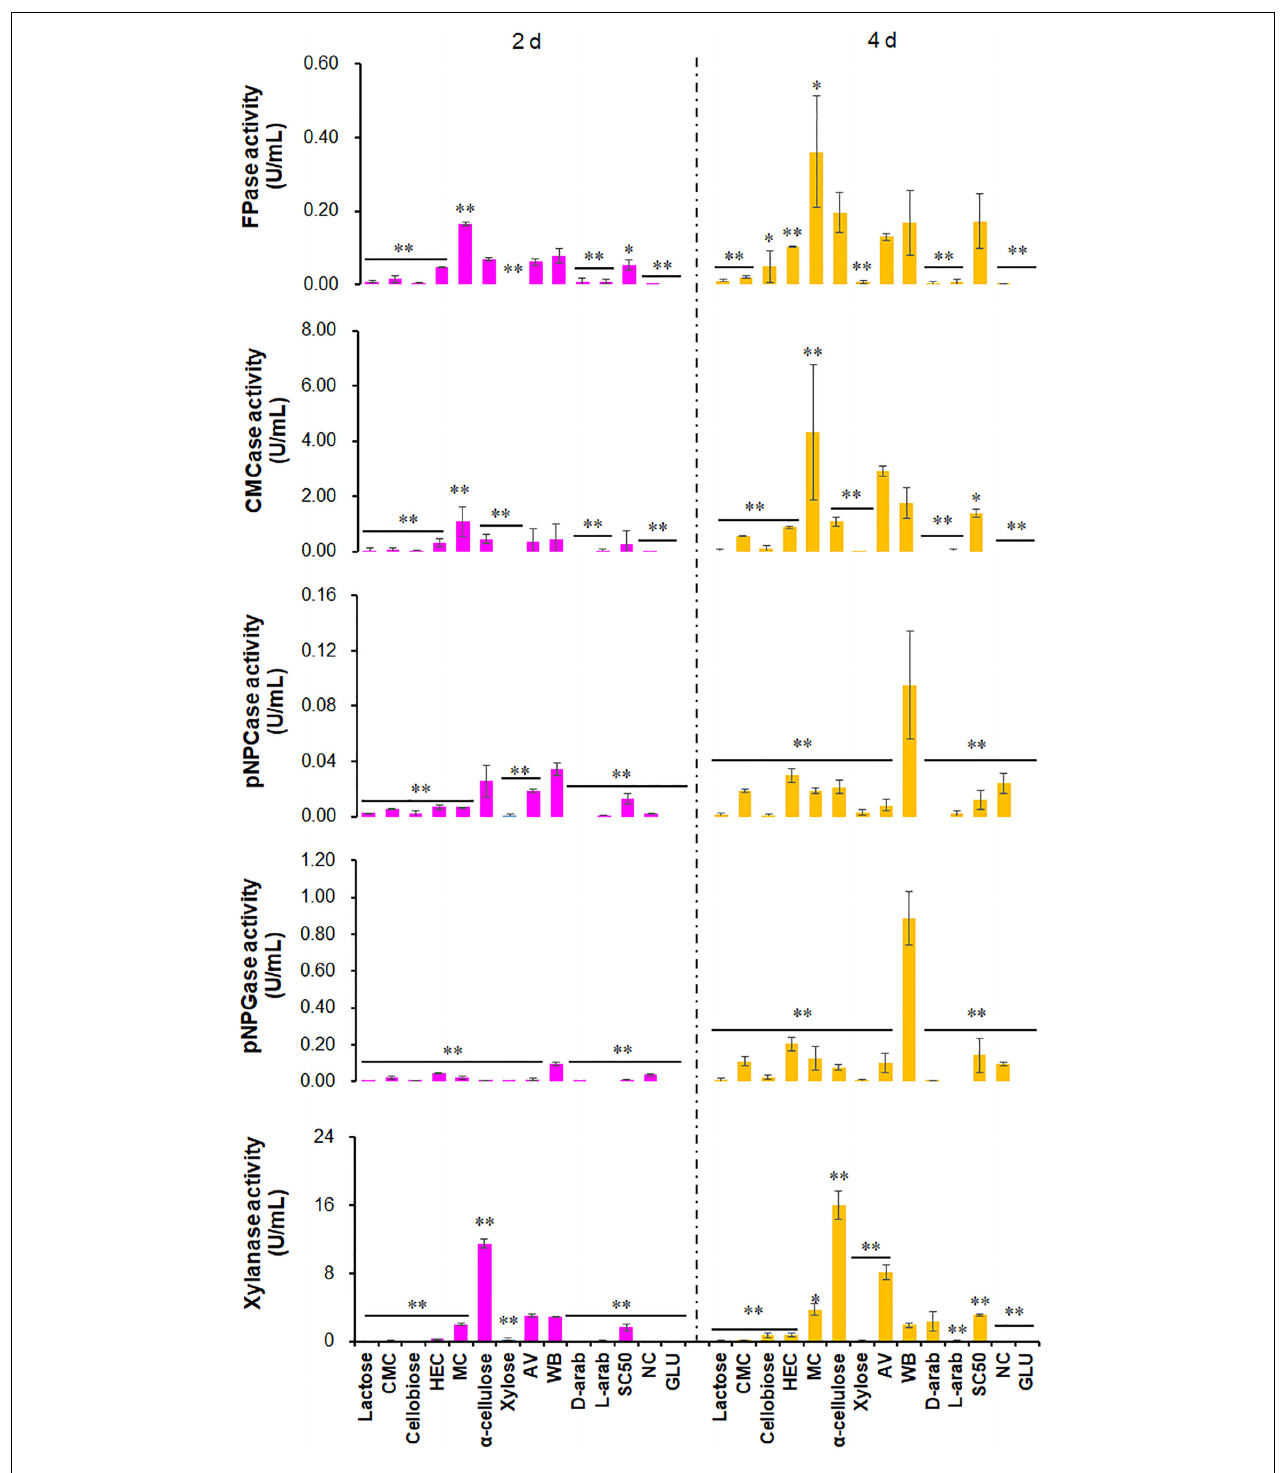
FIGURE 1 | Activities of crude enzymes produced by P. oxalicum strain (cid:49) PoxKu70 cultured on various carbon sources. Crude enzymes were collected from the (cid:49) PoxKu70 cultivated for 2–4 days after a transfer from GLU. ∗ , p ≤ 0.05; ∗∗ , p ≤ 0.01 indicate the significance of differences between the results on various carbon sources and WB. CMC, carboxymethylcellulose; HEC, 2-hydroxyethyl cellulose; MC, methyl cellulose; WB, wheat bran; AV, Avicel; D-arab, D-arabinose; L-arab, L-arabinose; SC50, Sigmacell cellulose; NC, no carbon source; GLU, glucose; FPase, filter paper cellulase; CMCase, carboxymethylcellulase; pNPCase, p -nitrophenyl- β -cellobiosidase; pNPGase, p -nitrophenyl- β -glucopyranosidase.